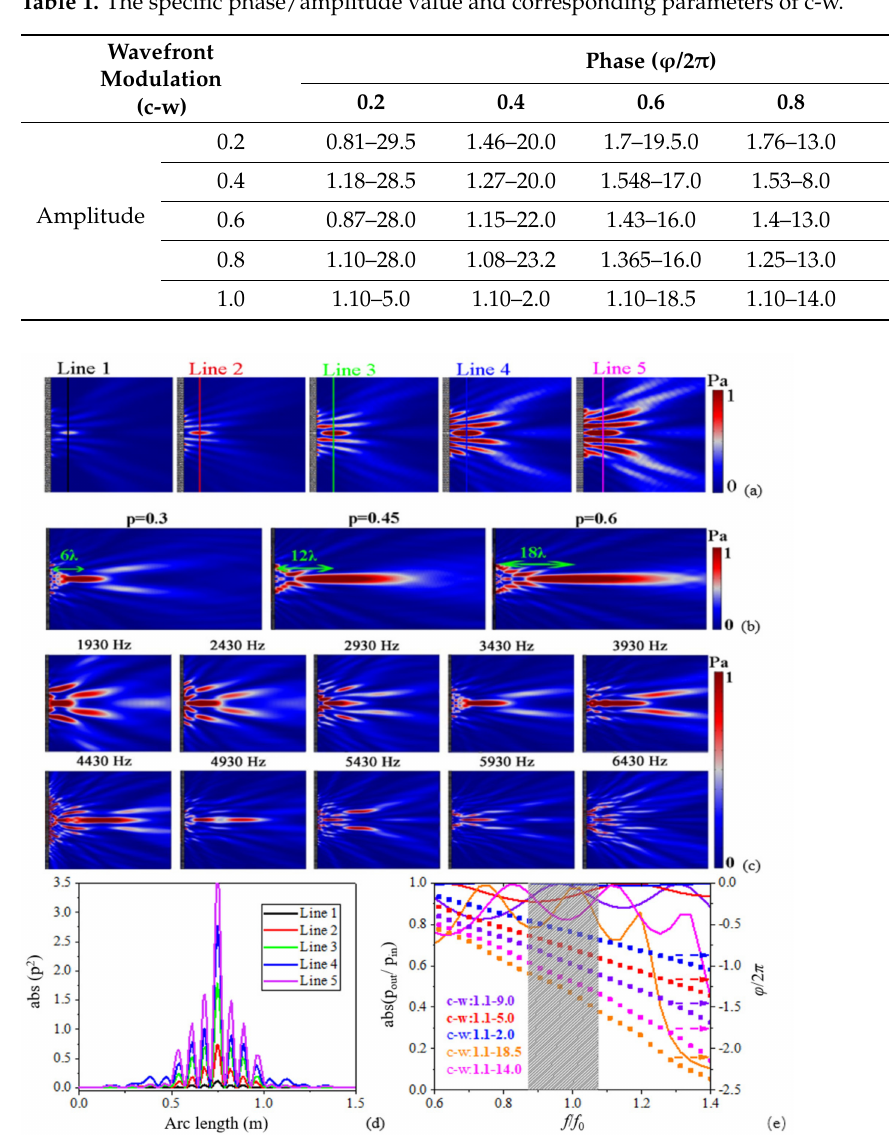
Figure 5. ( a ) Acoustic focusing with different intensities at 3430 Hz. ‘Line 1, Line 2, Line 3, Line 4, Line 5 (cid:48) are cut-lines of the focus; ( b ) Acoustic focusing with different focal lengths (the values of c and w for five types of waveguide units are c 1 = c 2 = c 3 = c 4 = c 5 = 1.1, w 1 = 5, w 2 = 2, w 3 = 18.5, w 4 = 14, w 5 = 9.) at 3430 Hz; ( c ) Acoustic focusing with different frequencies (the values of c and w for five types of waveguide units are c 1 = c 2 = c 3 = c 4 = c 5 = 1.1, w 1 = 5, w 2 = 2, w 3 = 18.5, w 4 = 14, w 5 = 9.); ( d ) Acoustic energy intensity curves with different cut-lines shown in Figure 4a; ( e )Transmittance and phase shift curves with different parameter